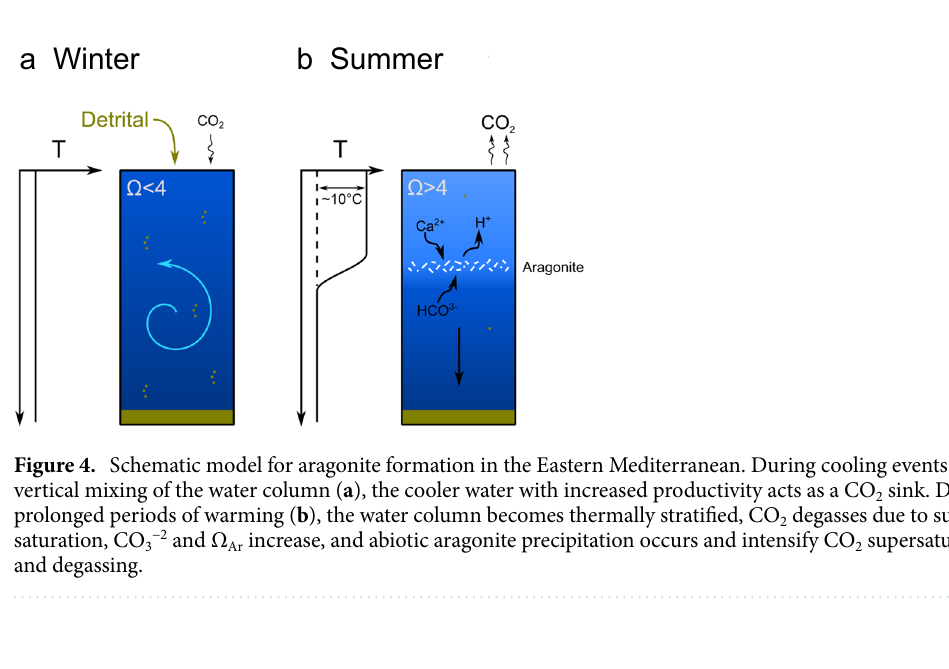
Figure 3. Time series of temperature in the upper 100 m of the water column at THEMO-1 station (early 2018 to early 2019) showing the summertime stratification of the water column.